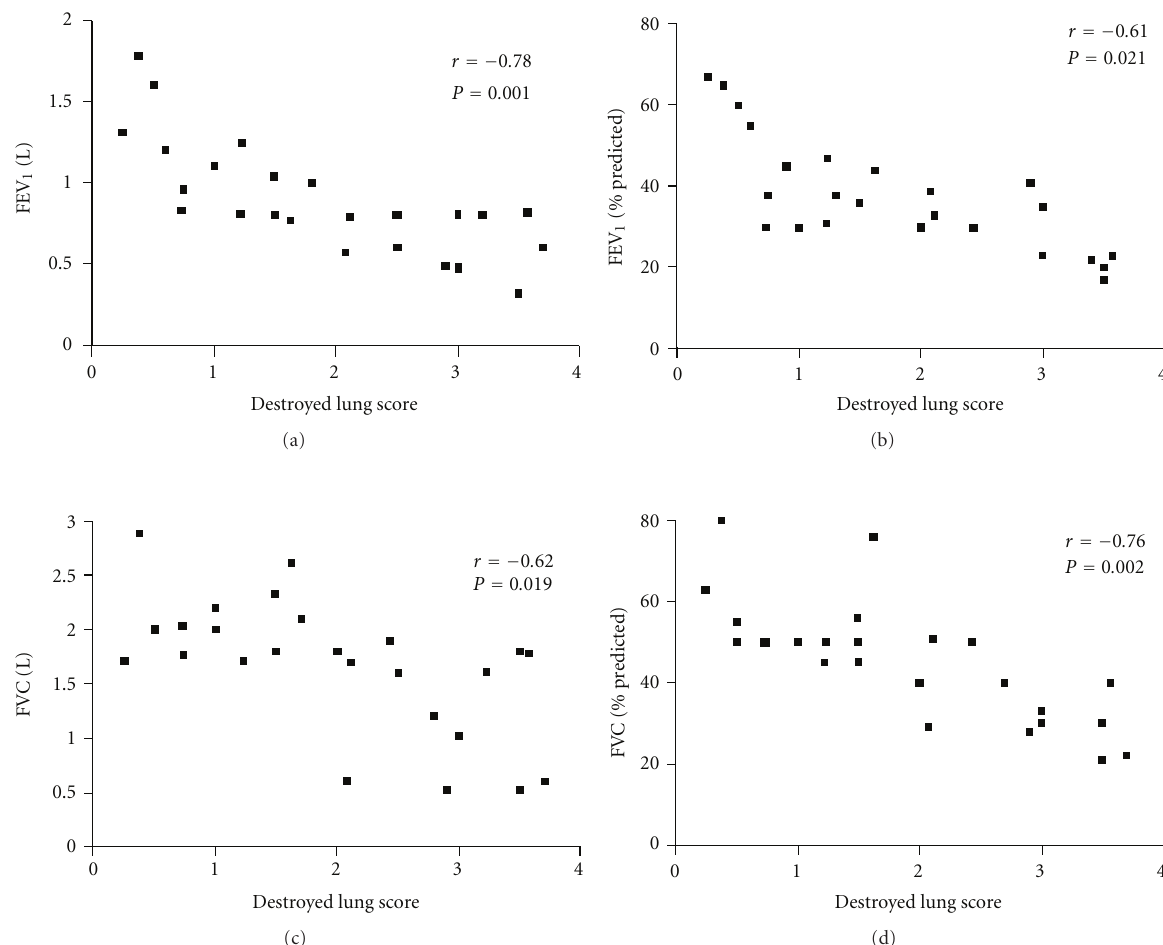
Figure 2: Illustrations showing close correlation between destroyed lung scores (DLS) and pulmonary function. (a) Relationship between DLS and FEV 1 (L). (b) Relationship between DLS and FEV 1 (%predicted). (c) Relationship between DLS and FVC (L). (d) Relationship between DLS and FVC (%